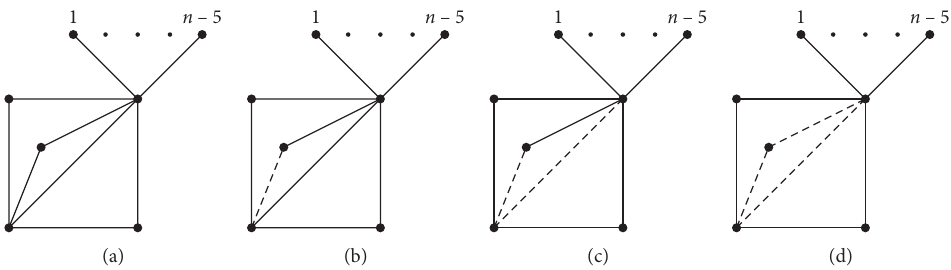
Figure 1: The four representatives of switching classes in tricyclic signed graphs S